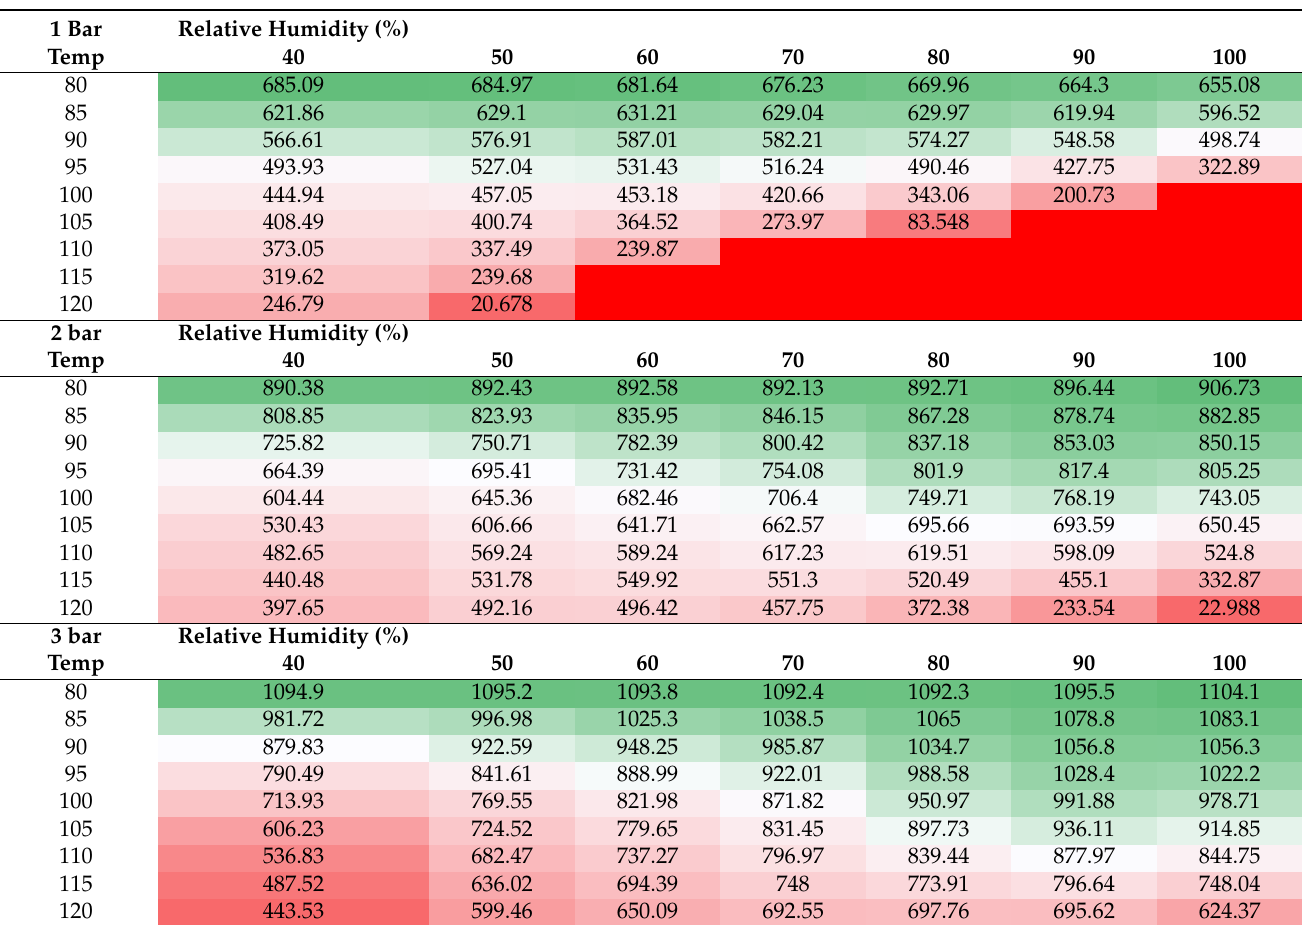
Table 9. Prediction of current density at 0.6 V across 80–120 ◦ C and 1–3 bar, highest performance in green and lowest performance in